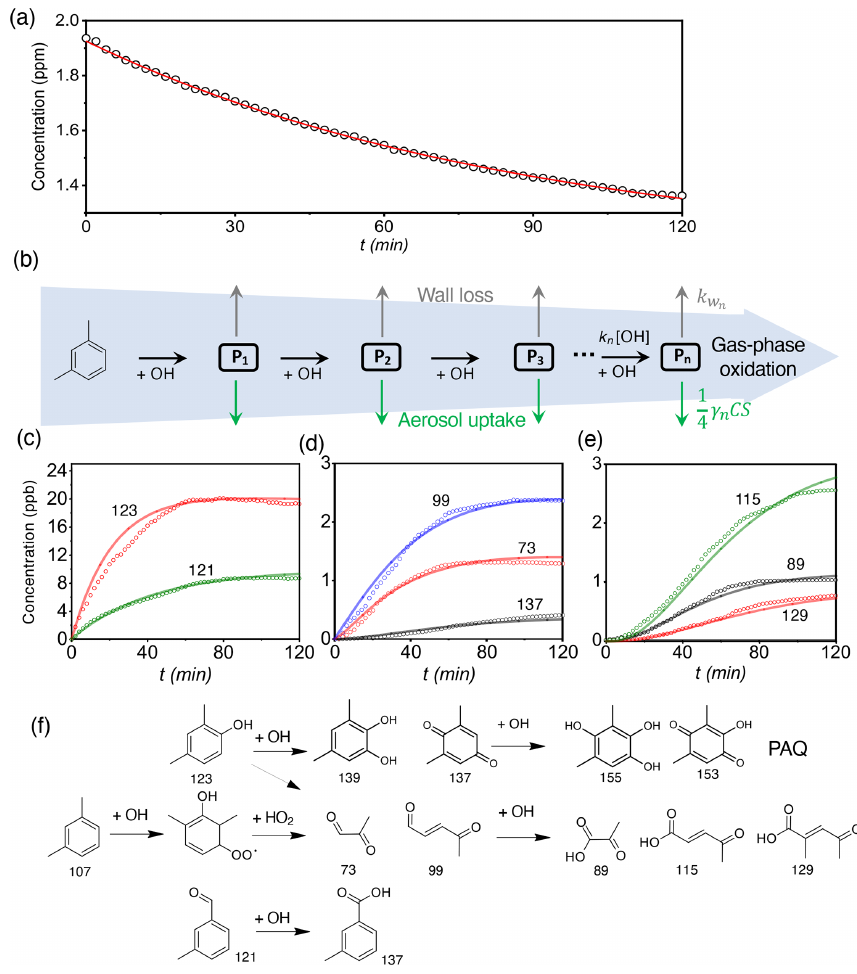
Figure 1. OH-initiated photooxidation of m -xylene. (a) Time-dependent concentration of m -xylene. The symbols are from the measure- ments, and the solid red line corresponds to exponential fitting of the m -xylene concentration. The initial concentration for m -xylene and the estimated steady-state concentration for OH are 1940ppb and 2.1 × 10 6 molec.cm − 3 , respectively, with a bimolecular rate constant of 2.4 × 10 − 11 cm 3 molec. − 1 s − 1 . (b) Schematic representation leading to the multi-generation product, P n , where n denotes the sequence of OH-initiated oxidation. The black, gray, and green arrows denote the gas-phase oxidation, chamber wall loss, and aerosol uptake, respectively. k n and k w are the rate coefficients for the gas-phase oxidation and wall loss, respectively, γ n represents the aerosol uptake coefficient, c is n the thermal velocity, and S is the aerosol surface area. (c–e) Time-dependent gas-phase concentrations of P 1 (c) , P 2 (d) , and P 3 (e) products. The symbols are from measurements, and the solid curves are simulated according to the tri-exponential kinetics. (f) The gaseous oxidation pathways leading to the detected products. The top row corresponds to the pathways leading to polyhydroxy aromatics/quinones (PAQ). The numbers in (c) to (f) represent the mass-to-charge ratio ( m/z ). All experiments are carried out for (NH 4 ) 2 SO 4 seed particles with 19ppbNH 3 at 298K and RH = 70%. Initiation of photooxidation by ultraviolet light occurs at t =